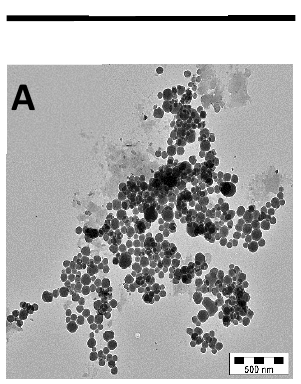
Figure 2. Effect of serum on E171 particles. Representative TEM images of E171 incubated in ( A ) water or ( B – D ) murine serum for 1, 4, and 24 h. TEM scale bars = 500 nm. Healthy mice were then intravenously treated with E171 (6 mg/kg b.w.), and the elemental Ti concentrations (originating from the TiO 2 NPs) in blood (Figure 3A) and filtering organs (Figure 3B) were determined by ICP-MS—from one hour up to one week after injection. Ti blood concentrations peaked one hour after injection, representing about